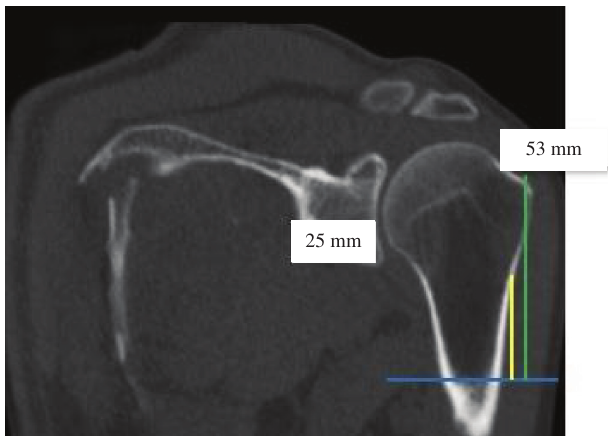
Figure 10. PM-change greater tubercle distance (green) was two times greater than PM-change of curvature distance (yellow) (ratio = 0.5).